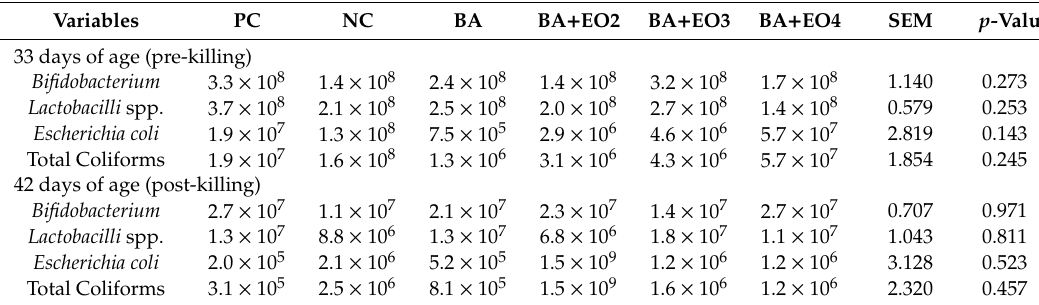
Table 4. E ff ect of experimental diets on the microbial concentration (CFU / g) in feces collected at 33 days of age (pre-killing) and on the cecal content collected at 42 days of age (post-killing) from piglets challenged with E. coli